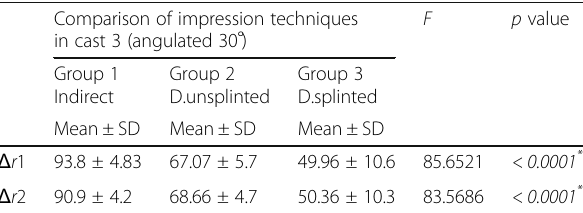
Table 6 Effect of implant angulation and impression technique on impressions by two-way ANOVA for Δ r 2 F Source of variation DF Mean square